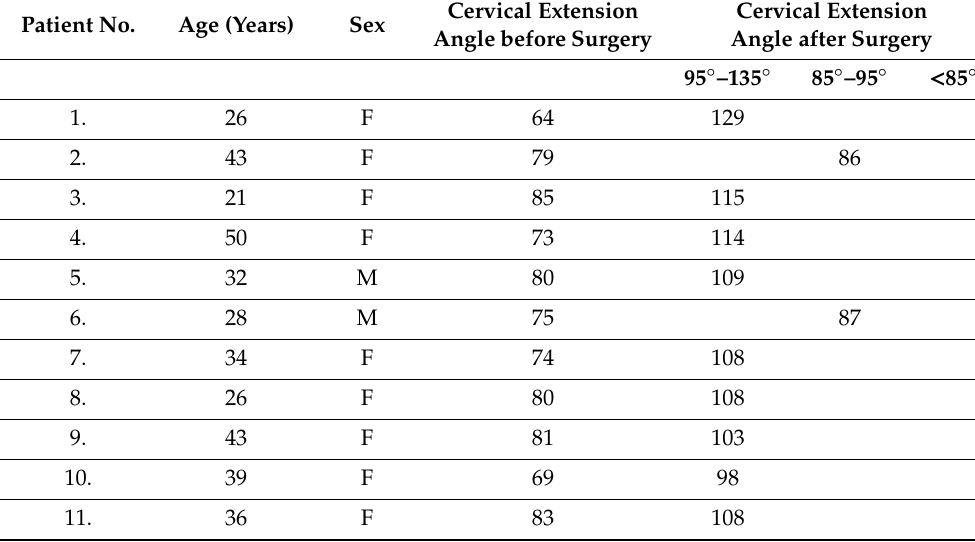
Table 3. Evaluation of functional outcomes using the cervical neck angle (mento-hyoido-sternal angle) before and after reconstruction with